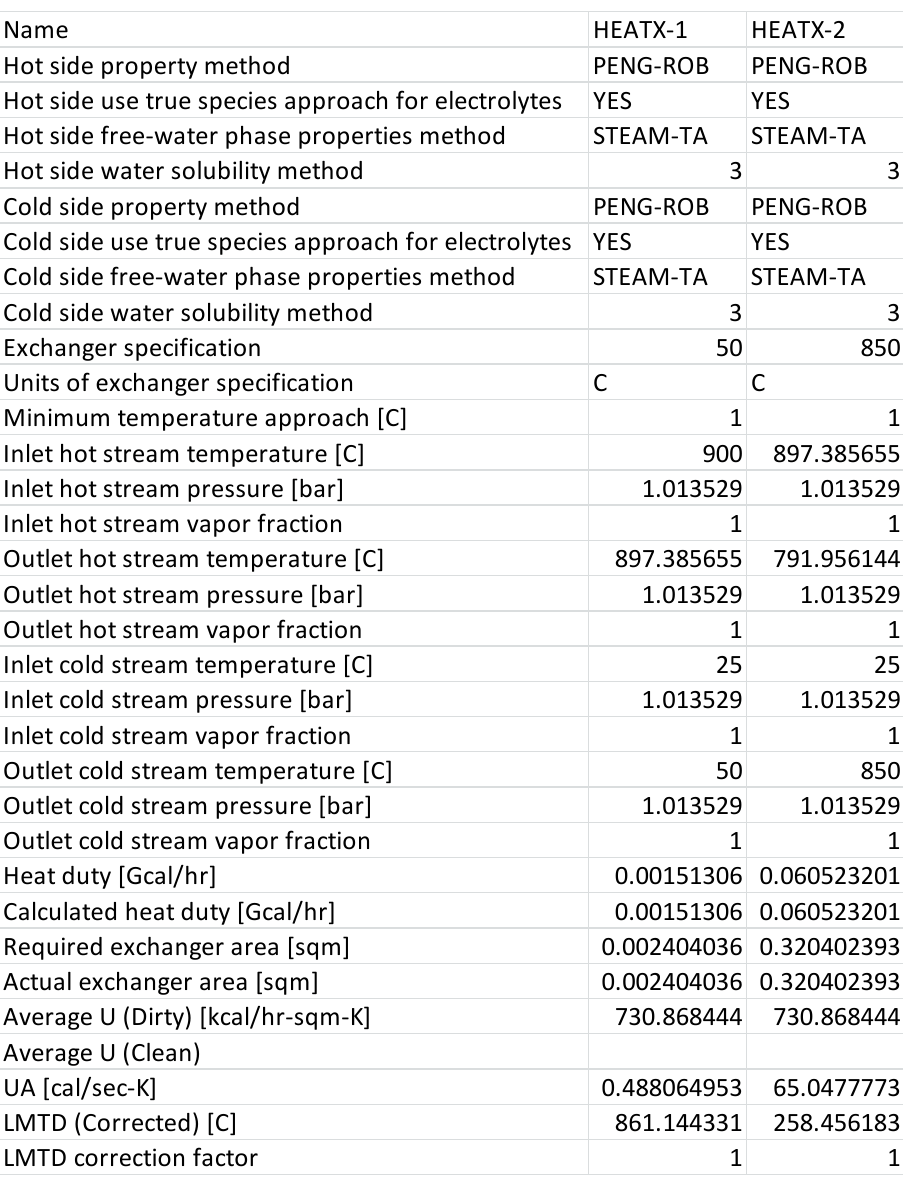
Figure A10. Gasification heat exchanger results.